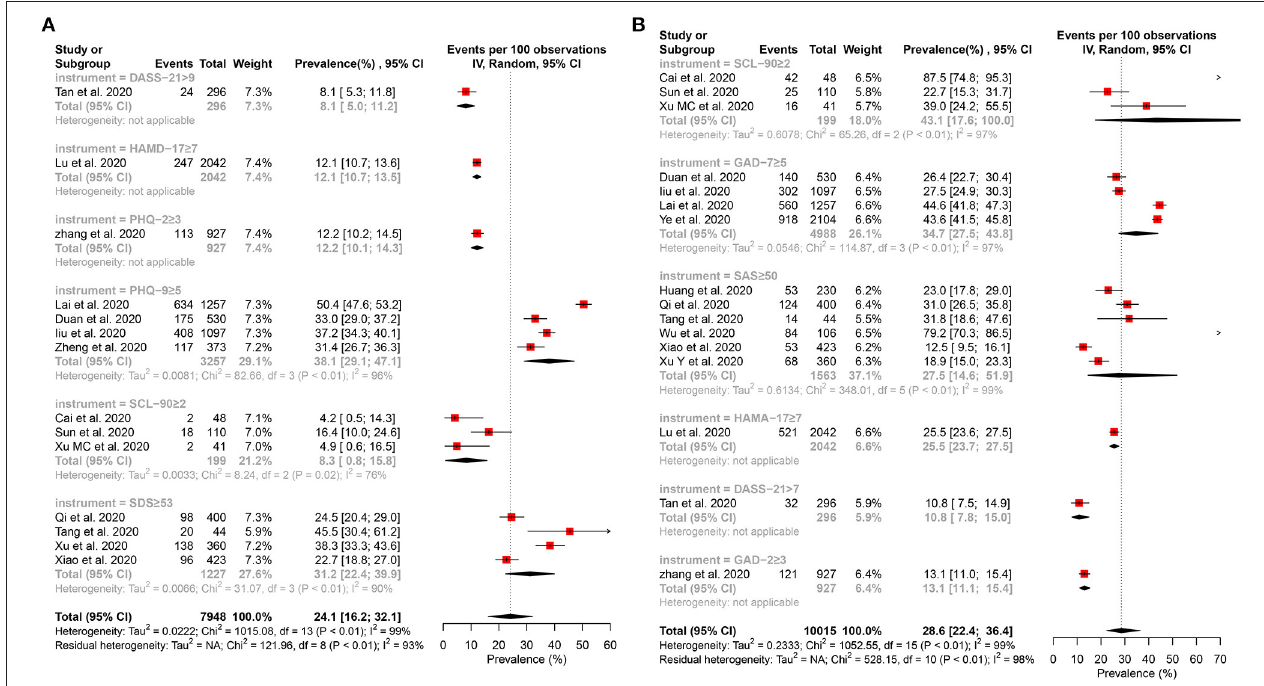
FIGURE 2 | Forest plot for the meta-analysis of the prevalence of depression and anxiety among healthcare workers. (A) Forest plot of the prevalence of depression. (B) Forest plot of the prevalence of anxiety.